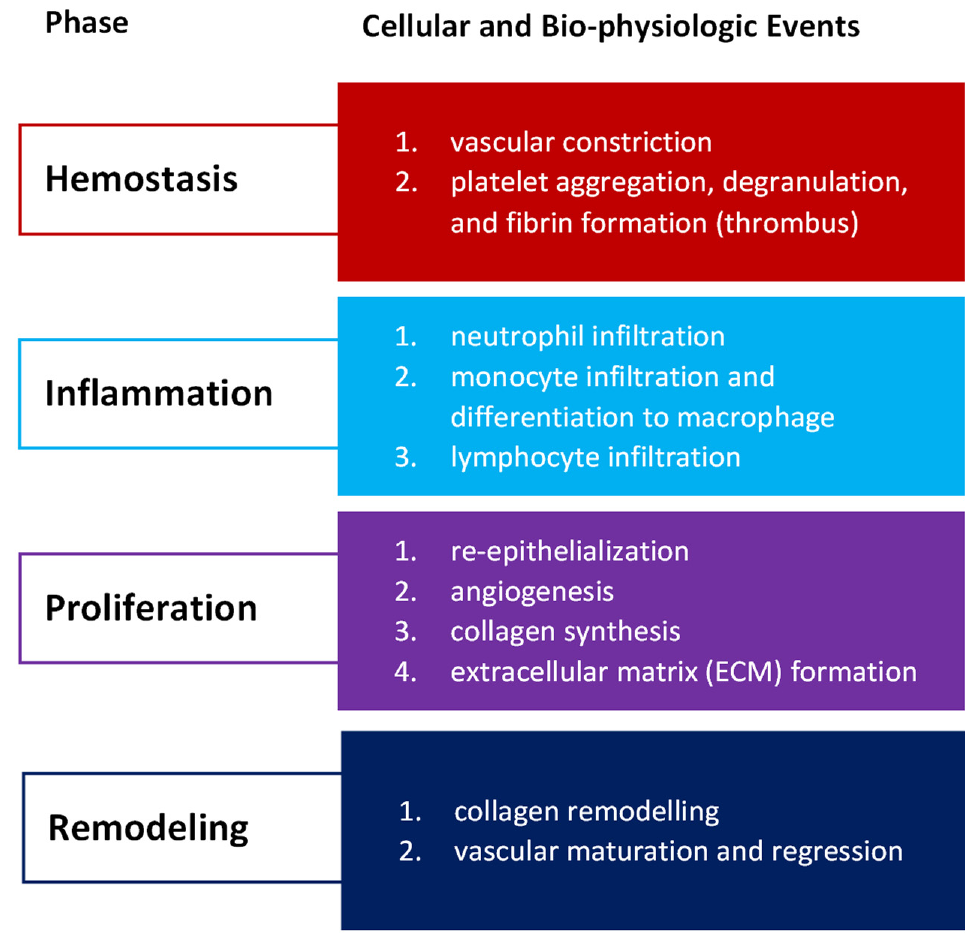
Figure 1. Cellular and bio-physiologic events occurring during the normal wound-healing process described by Gao and di Petro [12].